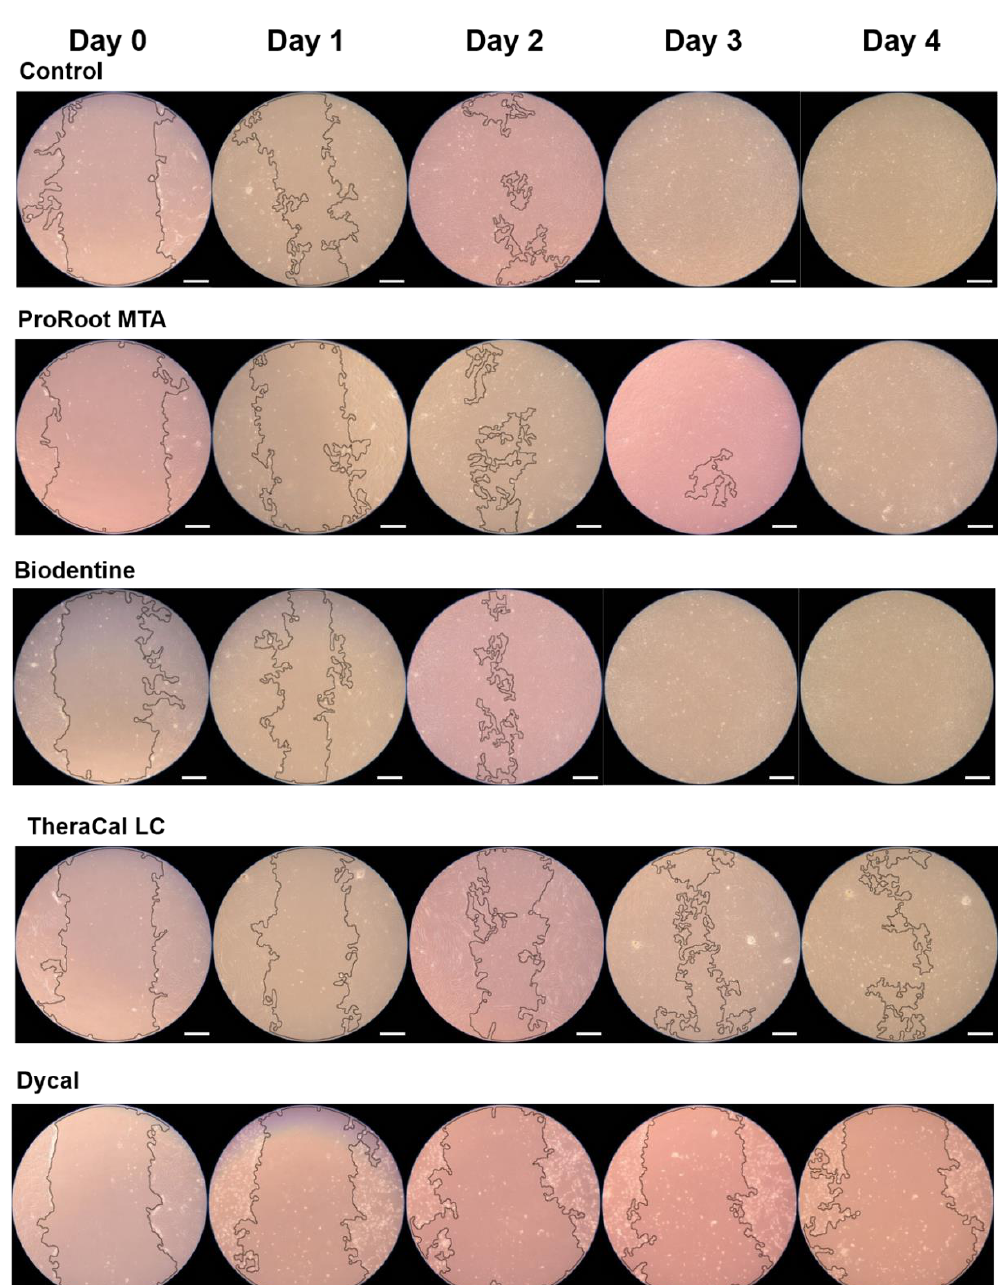
Figure 2. Evaluation of cell migration by wound healing assay. Different letters represent statistically significant differences among experimental groups.